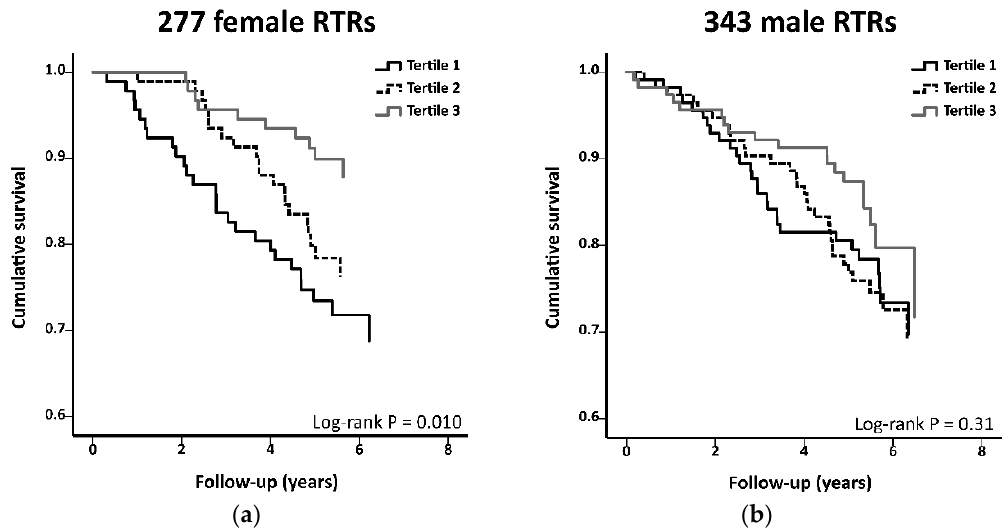
Figure 2. Kaplan–Meier curves for all-cause mortality according to tertiles of plasma insulin-like growth factor 1 (IGF1) in ( a ) female and ( b ) male renal transplant recipients (RTR). For female RTR, IGF1 levels of the tertiles 1, 2, and 3 are below 131 ng / mL, range between 131 and 181 ng / mL, and are above 181 ng / mL, respectively. For male RTR, IGF1 levels of the tertiles 1, 2, and 3 are below 141 ng / mL, range between 141 and 202 ng / mL, and are above 202 ng / mL, respectively.